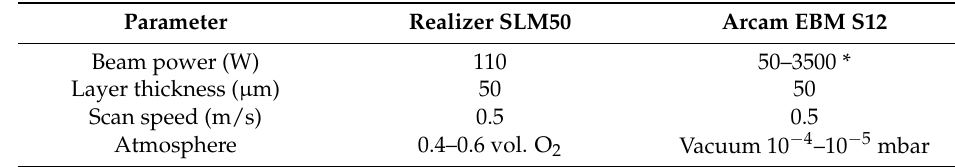
Table 2. SLM and EBM (Electron Beam Melting) process parameters used for samples with a 15-mm side length.